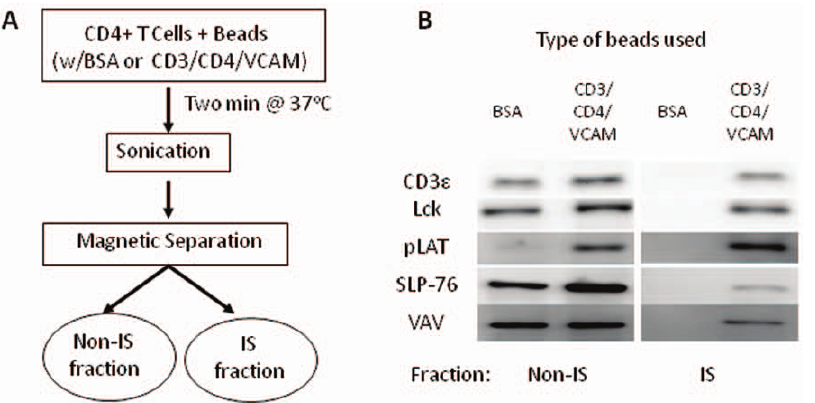
Figure 1. A schema for the stimulation of CD4 + T cells with antibody-coated magnetic beads and separation and characterization of the immune synapse (IS) and non-IS fractions. A: Purified murine CD4 + T cells were incubated for 2 min with control magnetic beads (BSA) or beads coated with anti-CD3 e , anti-CD4, and recombinant VCAM-1 (CD3/CD4/VCAM). Cells were then sonicated, and the IS and non-IS fractions separated using a magnet. B: Western blot analysis of the non-IS and IS fractions from control (BSA) or stimulated (CD3/CD4/VCAM) young T cells. The amount of sample (cell number equivalents) loaded on the IS lanes was 10 times that for the non-IS lanes. Shown is a representative blot from two independent experiments, each with n=3 for total n=6/age group.